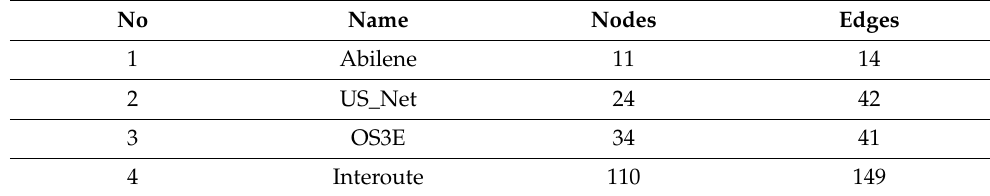
Table 10. Network